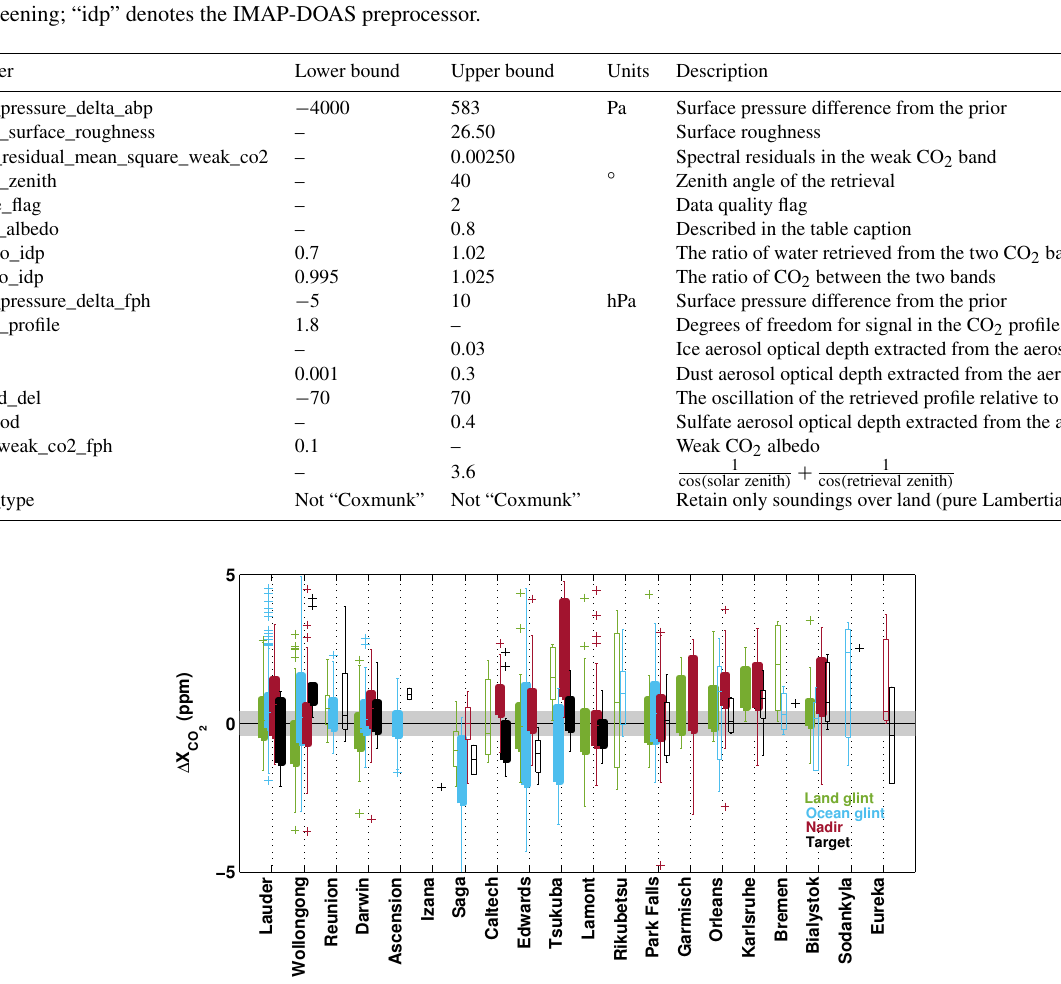
Figure 6. The site-to-site differences between the OCO-2 data and the coincident TCCON data, separated by observation mode. This is a “box plot”: the bottom and top edges of the box indicate the 25 and 75 percentile limits; whiskers represent the full range of the data, excluding the outliers (McGill et al., 1978). The outliers and sites for which only one coincident set of measurements is available are represented by plus (“ + ”) symbols. The grey shaded area indicates the ± 0.4ppm uncertainty in the TCCON values: deviations beyond the shading are more likely attributable to uncertainties in the OCO-2 data. Filled boxes indicate sites for which more than 10 coincident measurements were made. Open boxes have at least three coincident